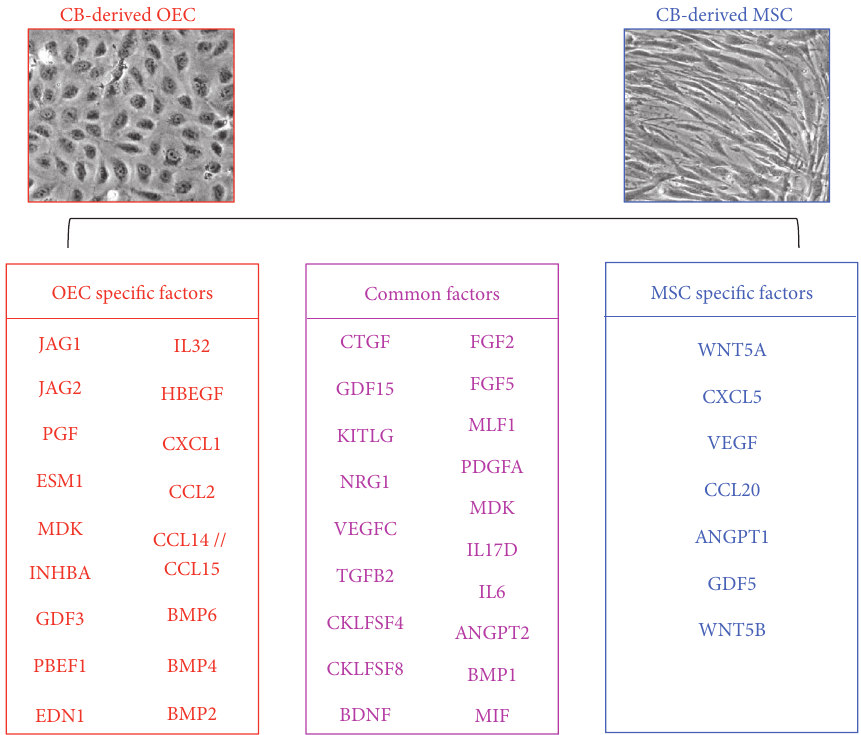
Figure 7: CKL − cell fate may be determined by specific molecules. Gene expression profiles were analyzed and compared between OECs and MSCs, and cell-specific upregulated genes are